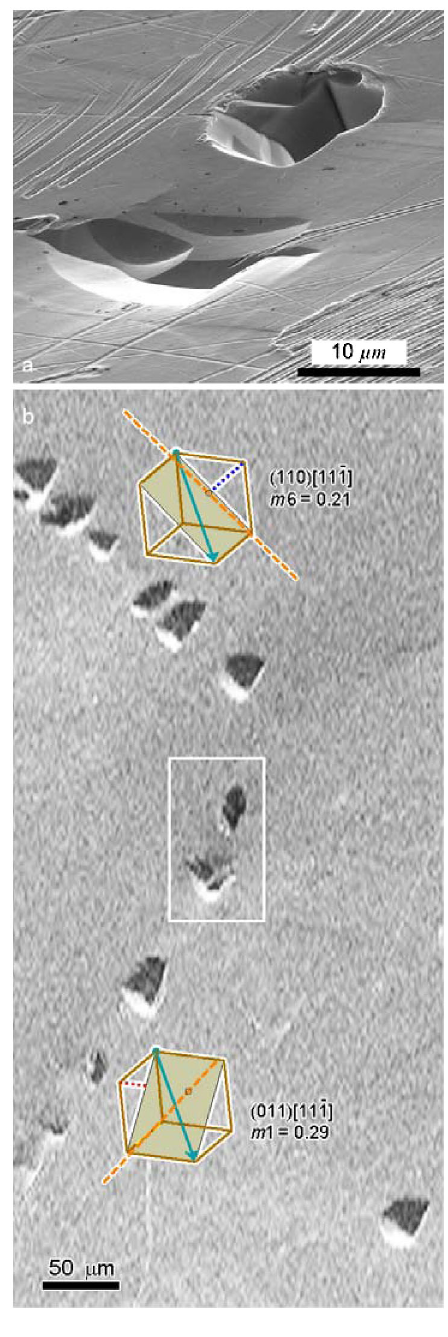
FIG. 9. (a) 70 (cid:2) tilted SEM image of a single grain showing etch pits in sample No. 3. (b) SEM image of sample No. 3 at lower magnification. The prisms illustrate the highest ( m 1 ) and the 6th highest ( m 6 ) resolved shear stresses (as indicated in caption of Fig. 7). The area enclosed in the white box is shown in (a) at greater magnification and rotated by 70 (cid:2) . 1